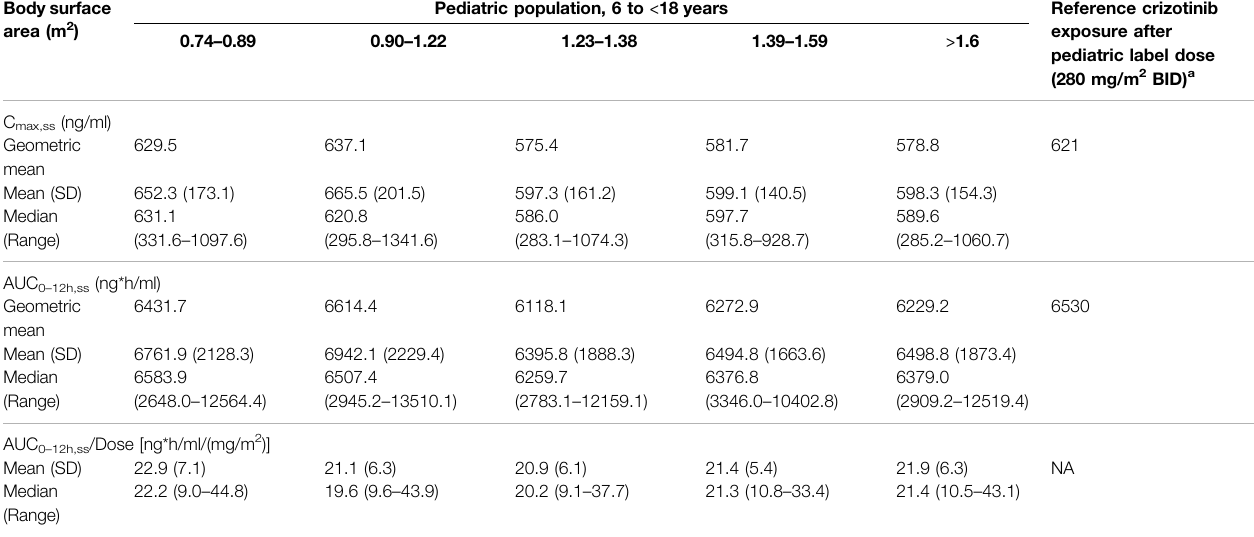
TABLE 6 | Simulated C max,ss and AUC 0 – 12h, ss for TQ-B3101M in virtual pediatric population after BSA-Tiered dosing regimen. Body surface area (m 2